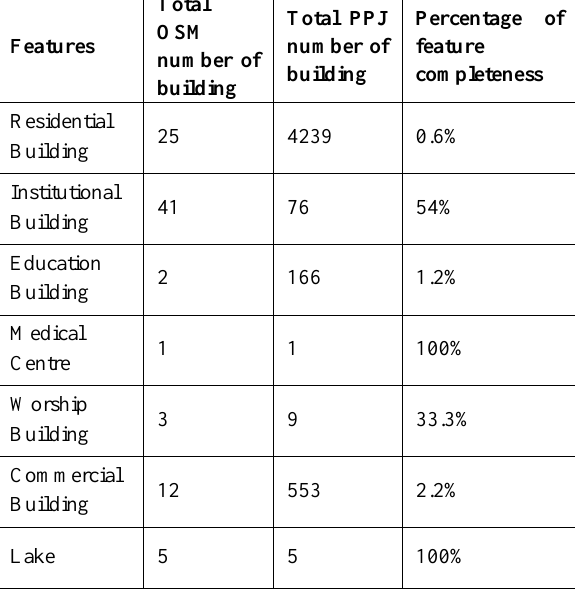
Table 7: Completeness of building features section one